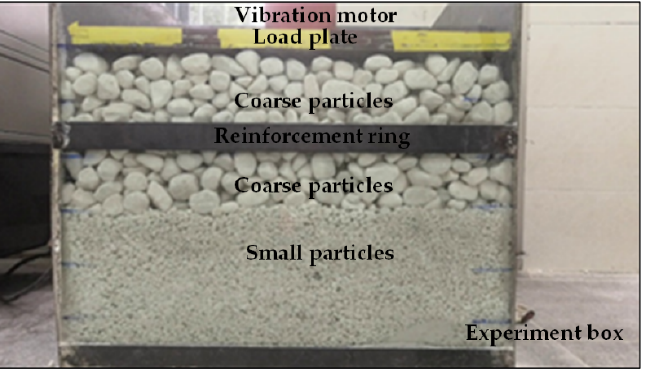
Figure 6. Experimental equipment.